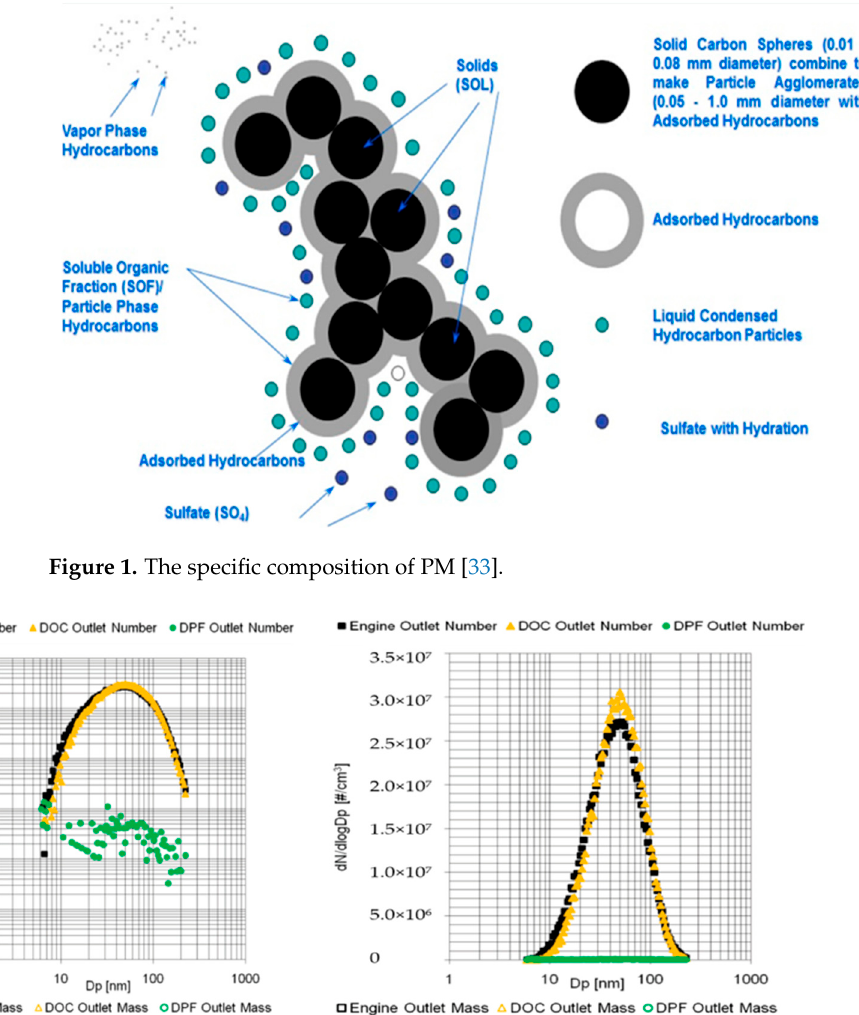
Figure 1. The specific composition of PM [33].